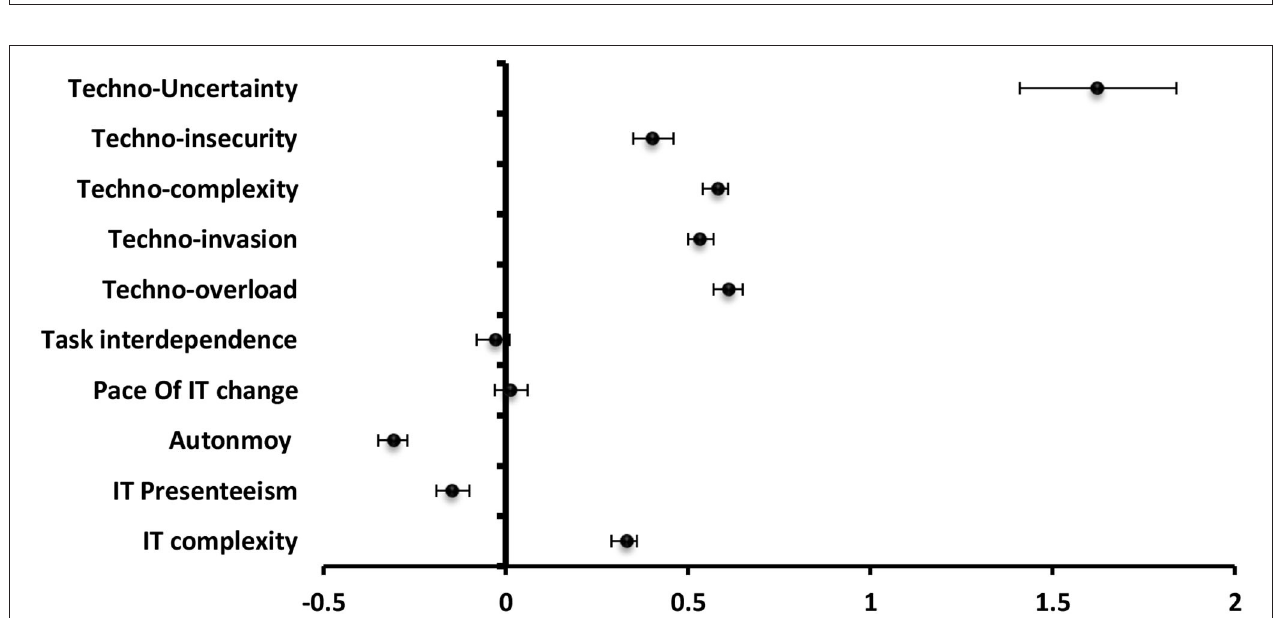
FIGURE 7 | Values of β and CI 95% for linear regression analysis of techno-stress items and job and technology characteristics as a predictor to strain among students.